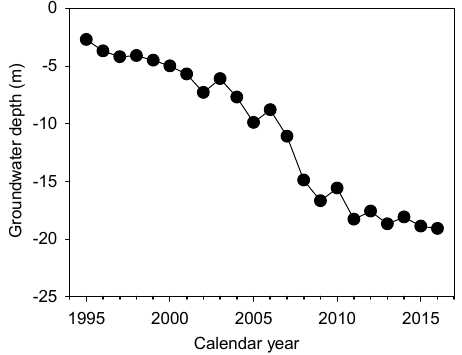
Figure 3. Changes in groundwater depth from 1995 to 2016.